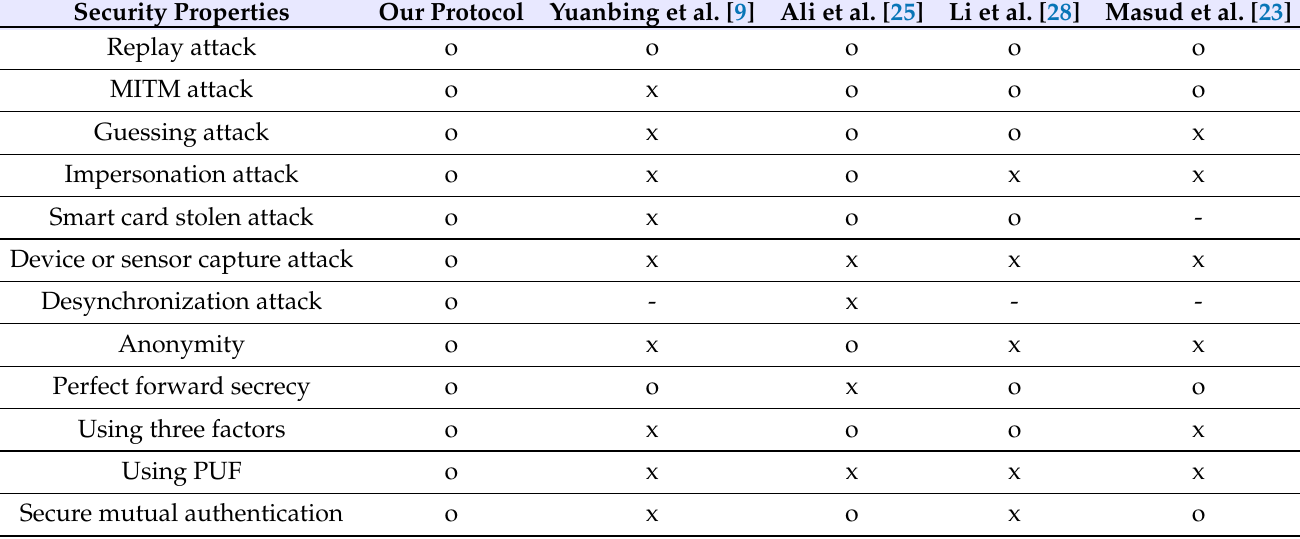
Table 2. Security and functional properties